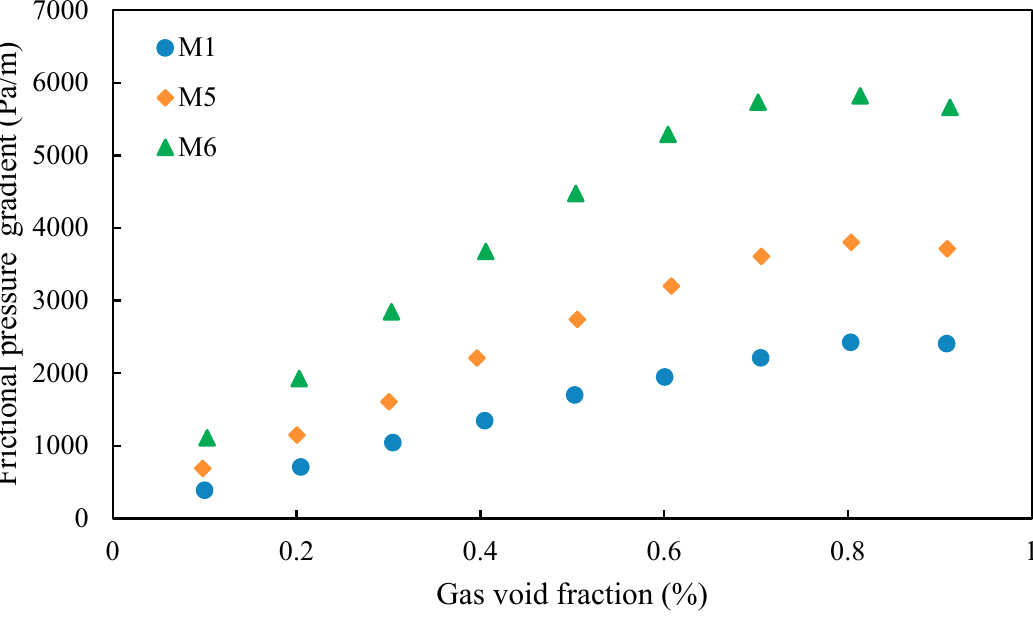
Figure 6. Effects of a gas void fraction on frictional pressure drop.